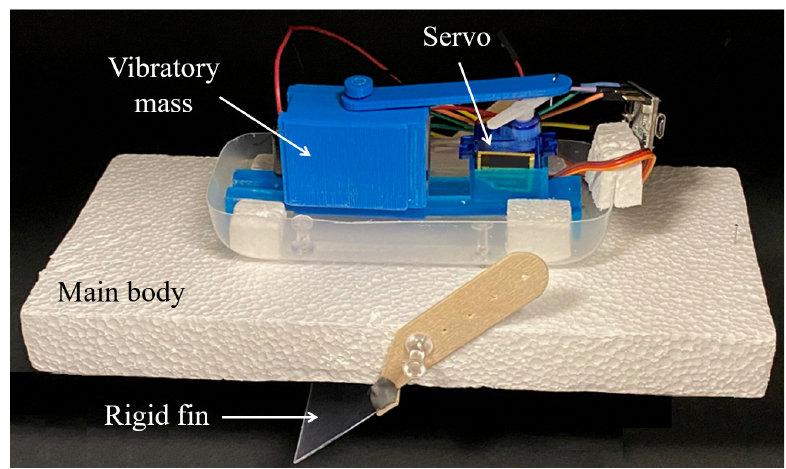
Figure 10. The vibratory swimmer used in experiments.